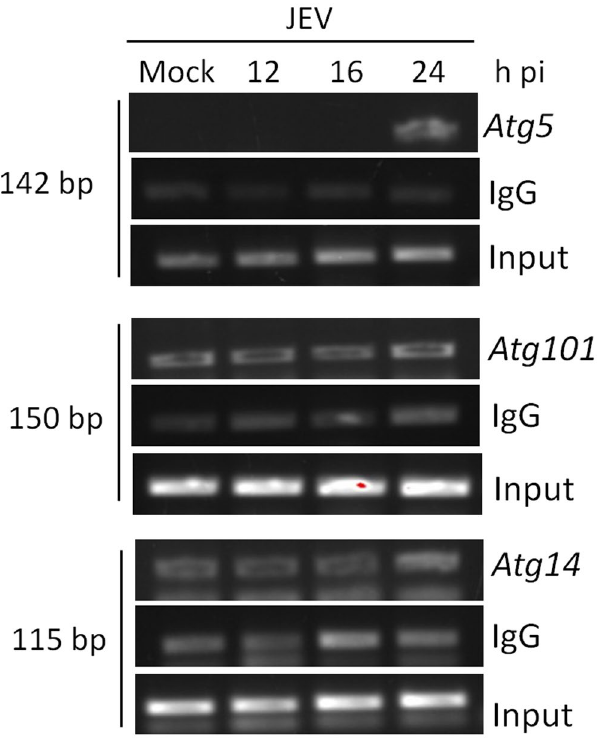
Figure 6. ATF3 binds to the promoter region of Atg5 . Neuro2a cells were mock-infected or infected with JEV (MOI 5) and at different time points chromatin immunoprecipitation was performed using ATF3-specific rabbit antibody or rabbit IgG (negative control for pull-down). Gene promoter-specific DNA was PCR amplified and separated on a 2% agarose gel. The relative abundance of pulled-down DNA during JEV infection as indicated by the PCR product is shown. The experiment was performed twice, and a representative figure is shown. Ten percent of total lysate was used as